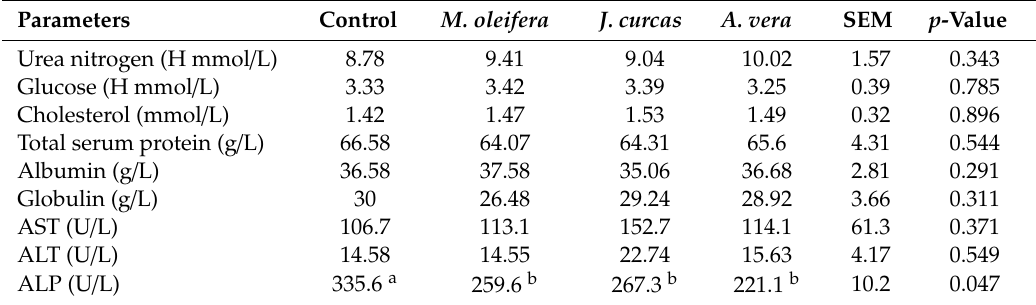
Table 3. Blood biochemical indices of SA Mutton Merino sheep drenched for 75 days with extracts of Moringa oleifera , Jatropha curcas and Aloe vera